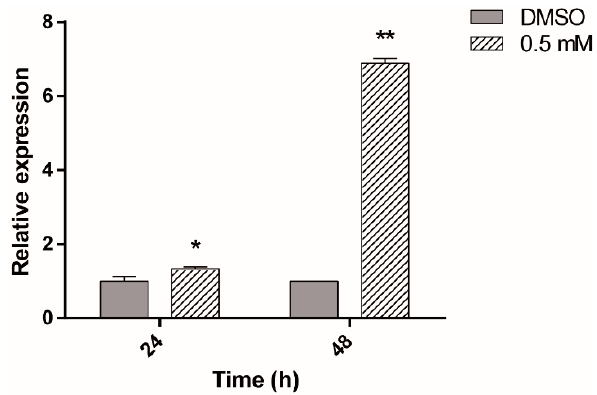
Figure 6. Relative-quantitative RT-PCR assay for hsp70 . Total RNA was obtained from parasites exposed to DMSO or 0.5 mM of ASA for 24 h and 48 h (* p < 0.02, ** p < 0.0001).